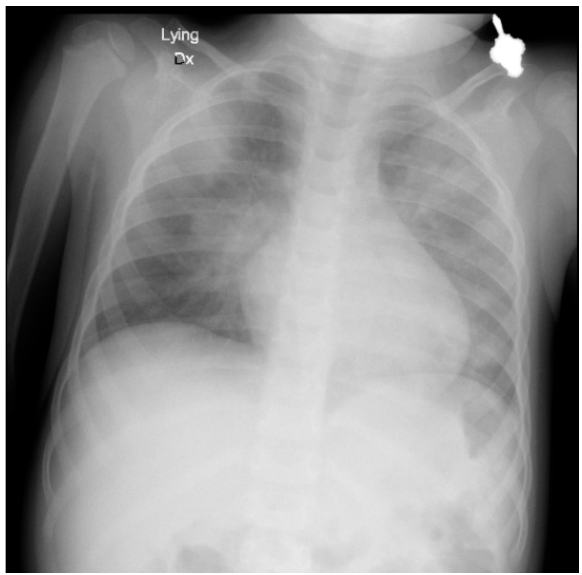
Figure 1. Day 2 Chest X-ray demonstrating bilateral pneumonia.